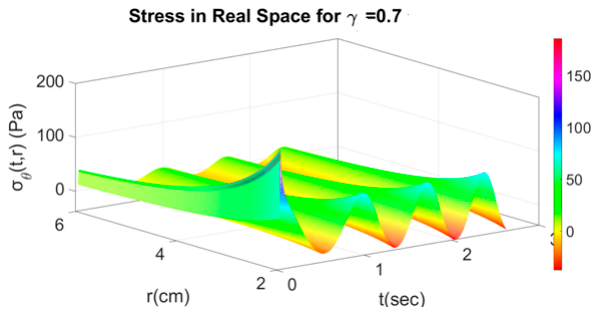
Figure 9. Distribution of the stress 𝜎 (cid:3087) (𝑡,𝑟) in the initial space for γ = 0.8.